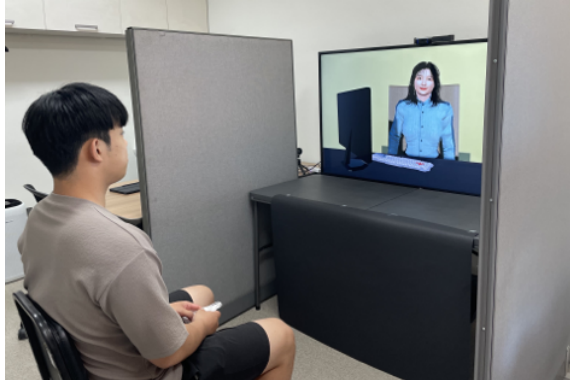
Figure 1. The experimental setup for Study 1.